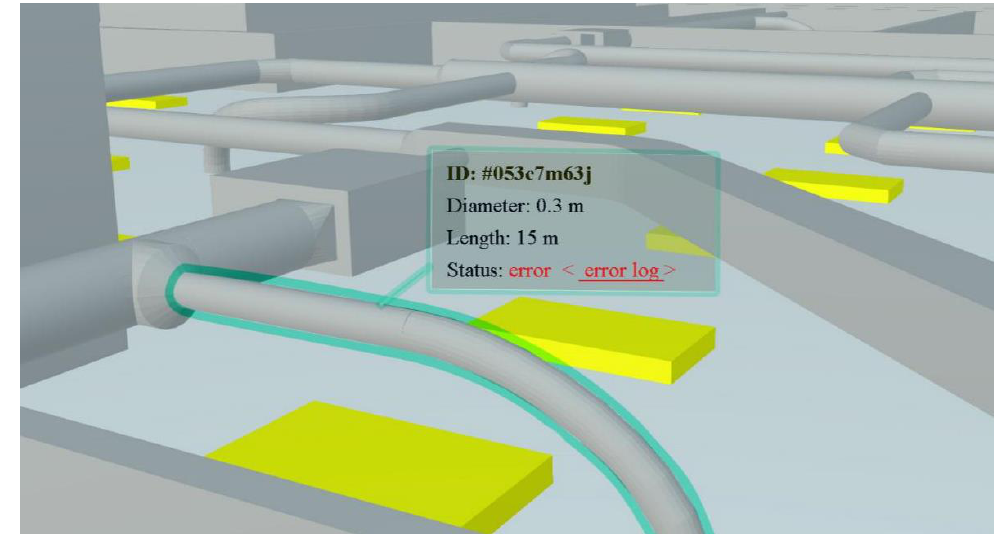
( d ) Exploratory visualization task: Pipeline troubleshooting. Figure 7. Screenshots of a typical three-level visualization task scene.